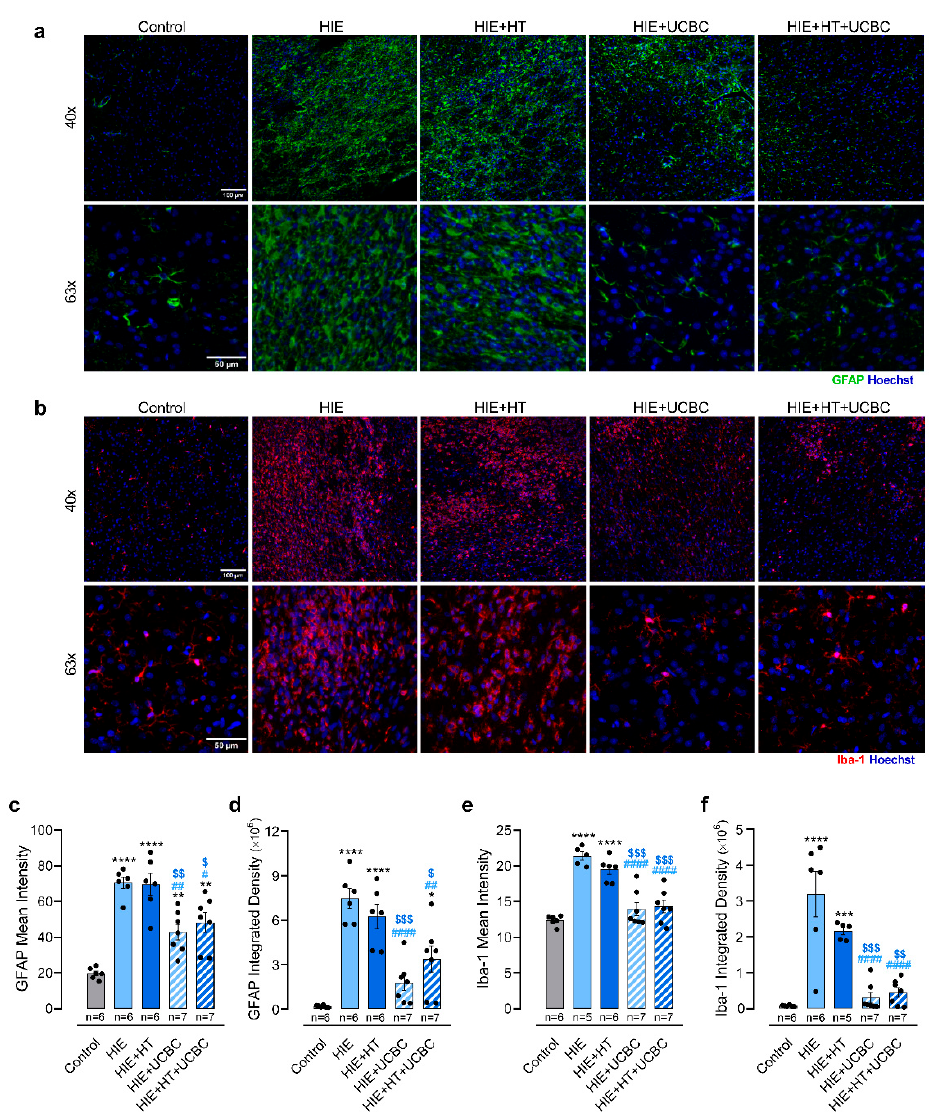
Figure 2. UCBC decreased GFAP and Iba-1 fluorescence intensity in the peri-infarct area 30 days after neonatal HI injury. Representative images of ( a ) GFAP (green) and ( b ) Iba-1 (red) immunostaining in the peri-infarct area were acquired at 40 × and 63 × magnification. Quantification of GFAP mean intensity ( c ), integrated density levels ( d ), Iba-1 mean intensity ( e ) and integrated density levels ( f ) at P40. The nuclei were counterstained with Hoechst 33342 (blue). Data are expressed as mean ± SEM of five to seven animals per group (Tables S6–S9). Statistical analysis was performed using one-way ANOVA coupled with Tukey’s multiple comparison test (* p < 0.05, ** p < 0.01, *** p < 0.001 and **** p < 0.0001 compared to the control; # p < 0.05, ## p < 0.01, and #### p < 0.0001 compared to HIE; $ p < 0.05, $$ p < 0.01, and $$$ p < 0.001 compared to HIE + TH; Table S16).